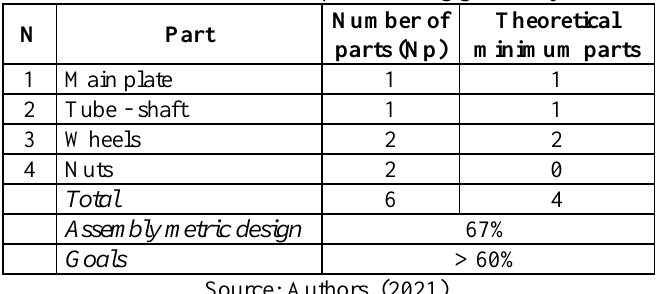
Table 4: Functional conceptual landing gear analysis.